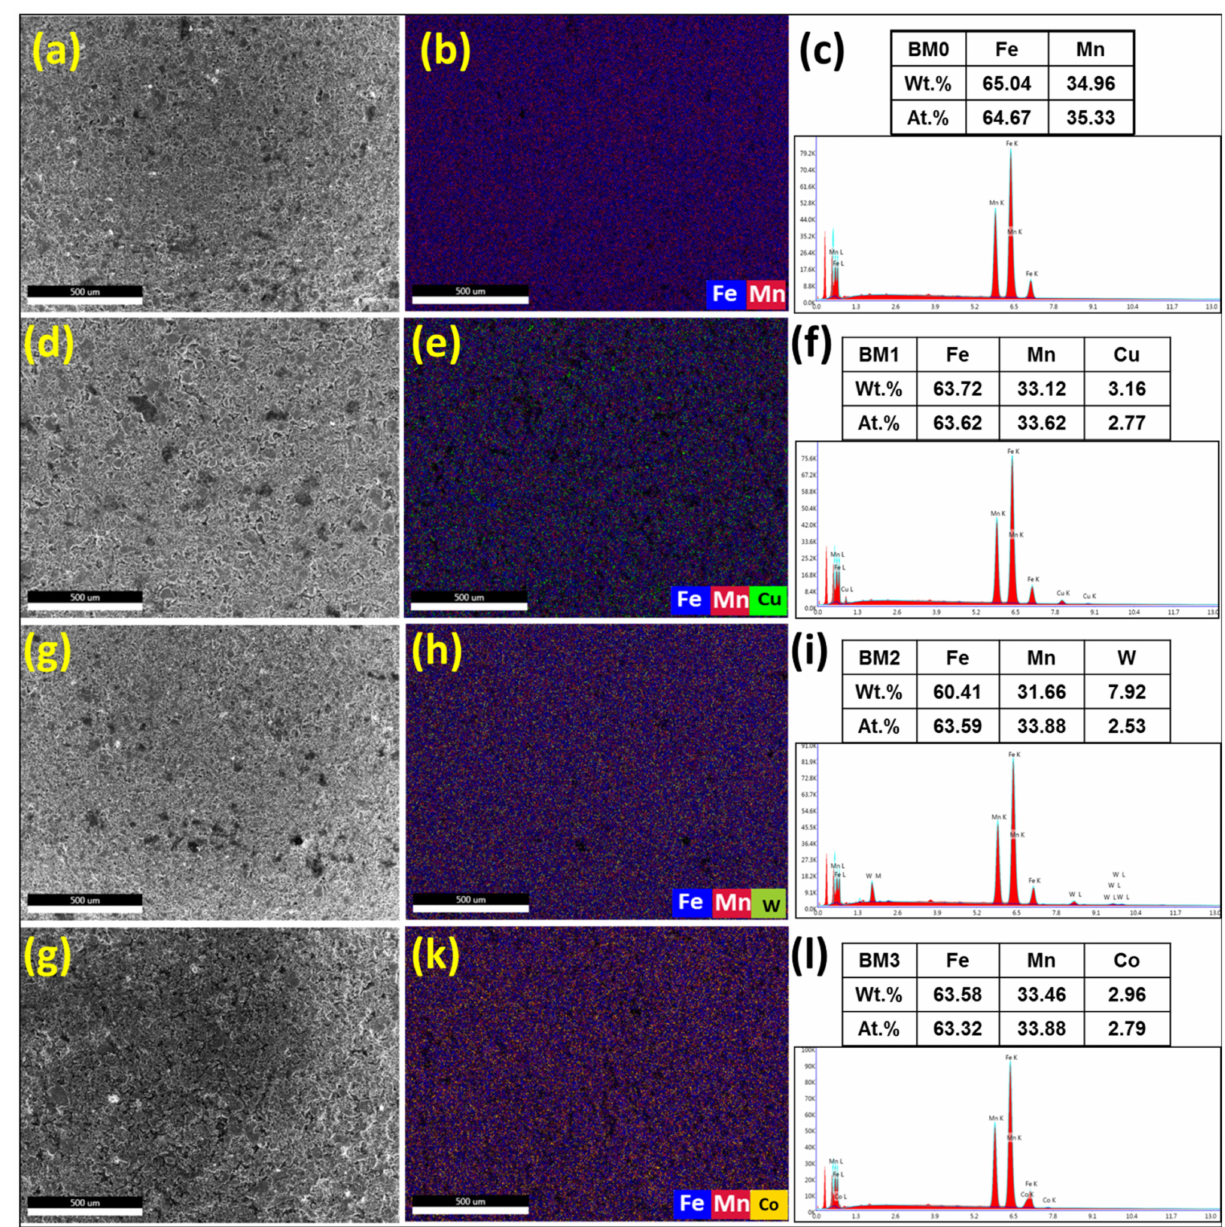
Figure 7. Secondary electron images, overlay elemental dispersion and EDS composition analysis results of the compacted samples: ( a – c ) the results for BM0 alloy; ( d – f ) the results for BM1 alloy; ( g – i ) the results for BM2 alloy; and ( j – l ) the results for BM3